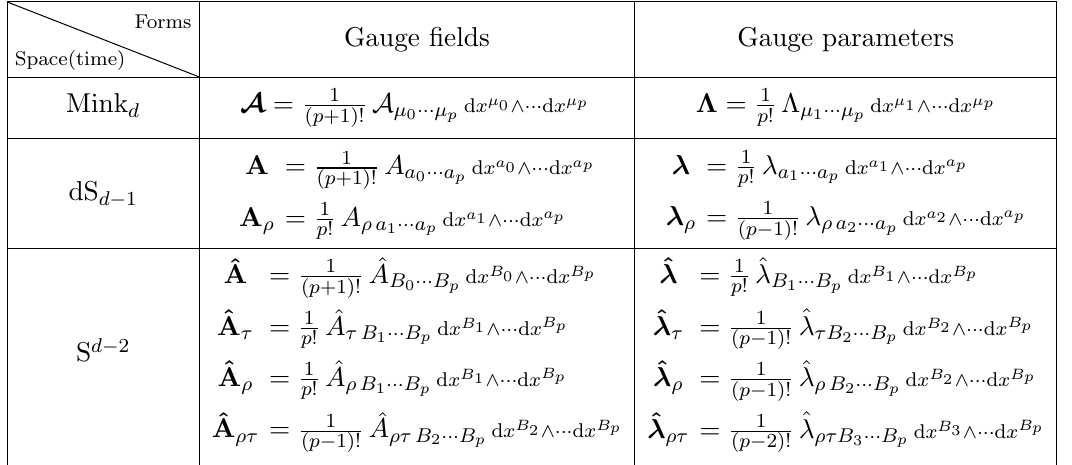
Figure 2 . Embedding the de sitter space in global patch as (cid:26) -constant slices of Minkowski pace with (cid:26) 2 = x (cid:22) x (cid:22) . The (cid:26) 0 ! 1 region gives the dS d (cid:0) 1 at the boundary of the Minkowski space.